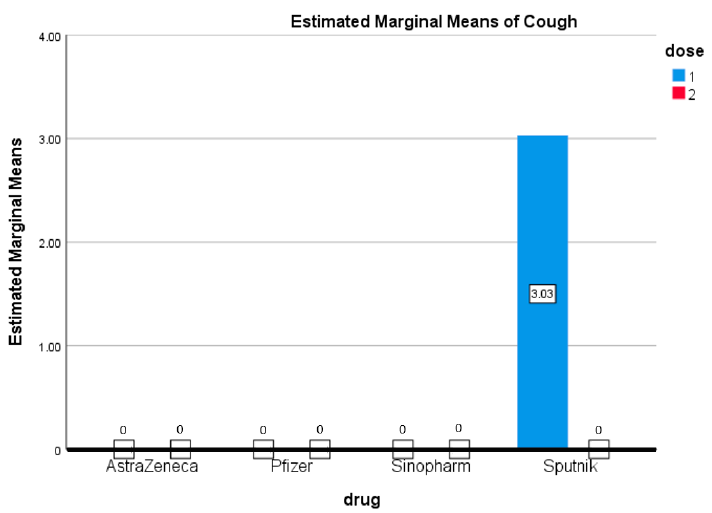
Figure 6. Cough. Estimated marginal means of cough after first and second doses of vaccines used in the Kingdom of Bahrain.